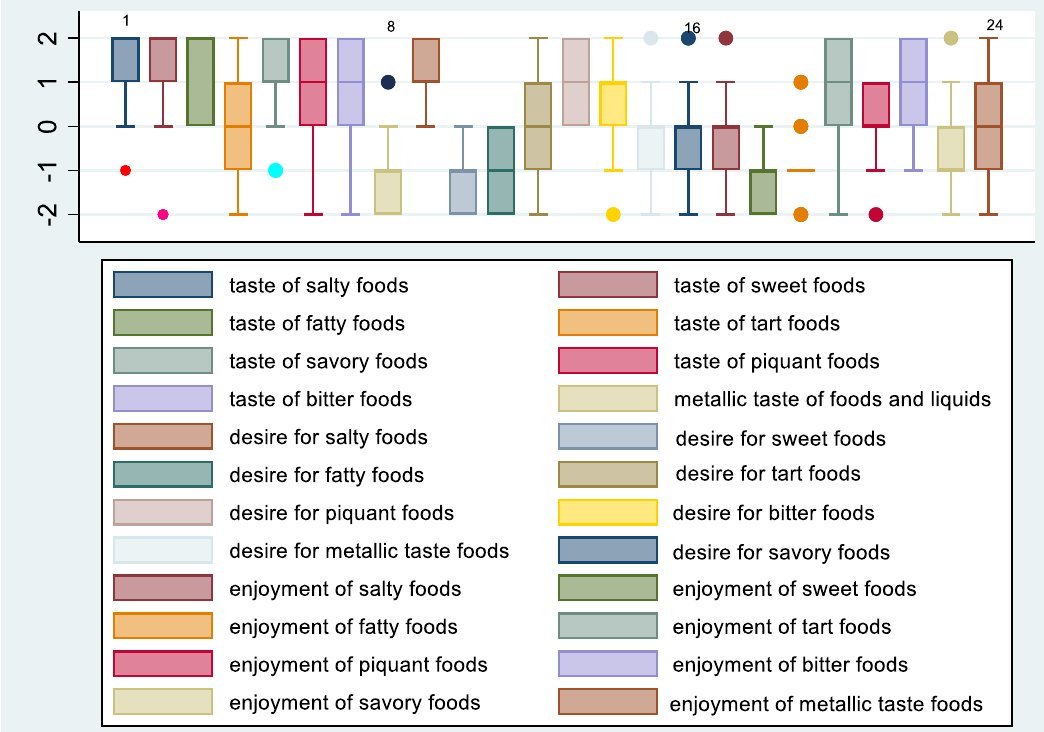
Figure 4. Change in taste, desire, and enjoyment 12 months after SG in males.